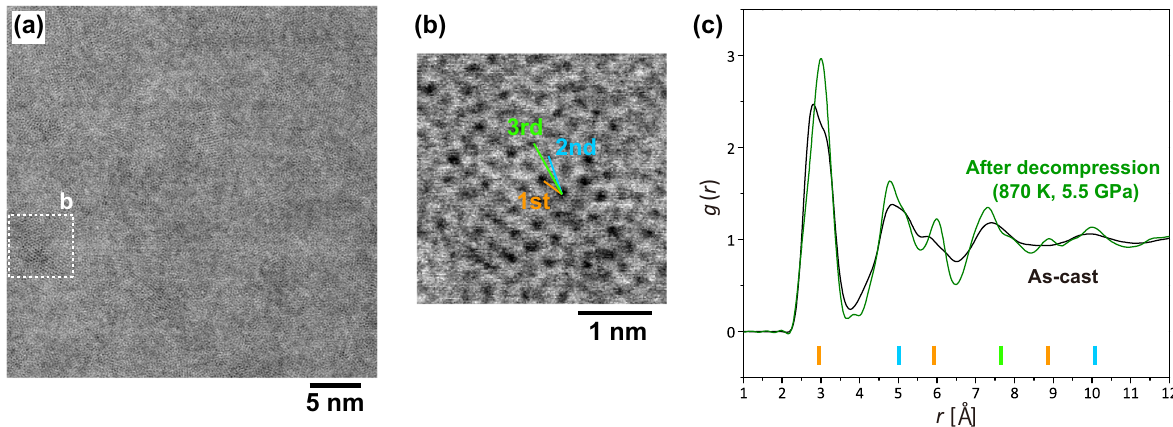
Fig. 5 High-magni fi cation BF-STEM images of the pHPQ Zr 50 Cu 40 Al 10 sample synthesized at 5.5 GPa and 880 K. a BF-STEM image of the sample. b High-magni fi cation version of image in a . Atomic distances in the nano-ordered region are estimated to be the fi rst (orange), second (light blue), and third (light green) neighbor distances of ~3.0 Å, ~5.0 Å, and ~7.6 Å, respectively. c Comparison between the atomic neighbor distances in b and g ( r ). Black and green curves denote g ( r ) of the as-cast sample, and the pHPQ sample treated at 5.5 GPa and 870 K, respectively. Orange, light blue, and light green vertical bars denote the multiple values of the fi rst, second, and third-neighbor distances, respectively.